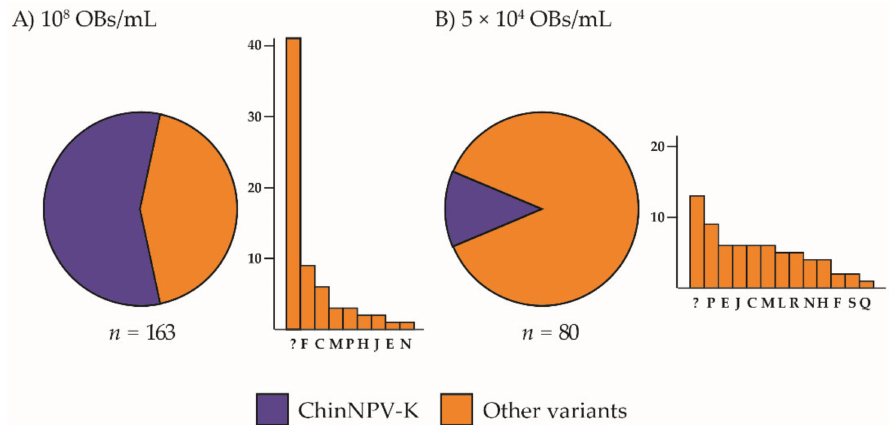
Figure 2. Prevalence of ChinNPV-K REN profiles in OB samples from virus-killed Chrysodeixis includens fifth instar larvae after inoculation with ChinNPV-K. Circular charts represent the proportions of REN profiles of ChinNPV-K and other variants in progeny OBs recovered from virus-killed larvae that had been inoculated with ( A ) 10 8 OBs/mL or ( B ) 5 × 10 4 OBs/mL. A bar chart is depicted next to each circular chart to indicate which REN profiles were recovered among the other variants. The y -axis indicates the number of insects that showed a particular dominant REN profile in the progeny OBs and the x -axis indicates each of the REN profiles observed in descending frequency; n indicates the number of insects analyzed. Novel REN profiles were classified as unknown and are shown as “?” in bar